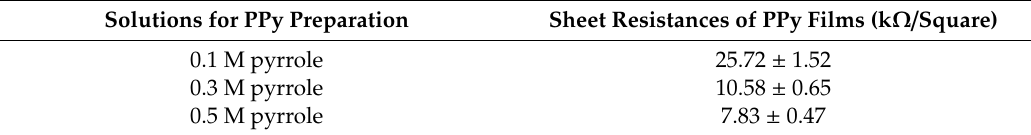
Table 2. The sheet resistances of PPy films prepared by di ff erent concentrations of pyrrole. Solutions for PPy